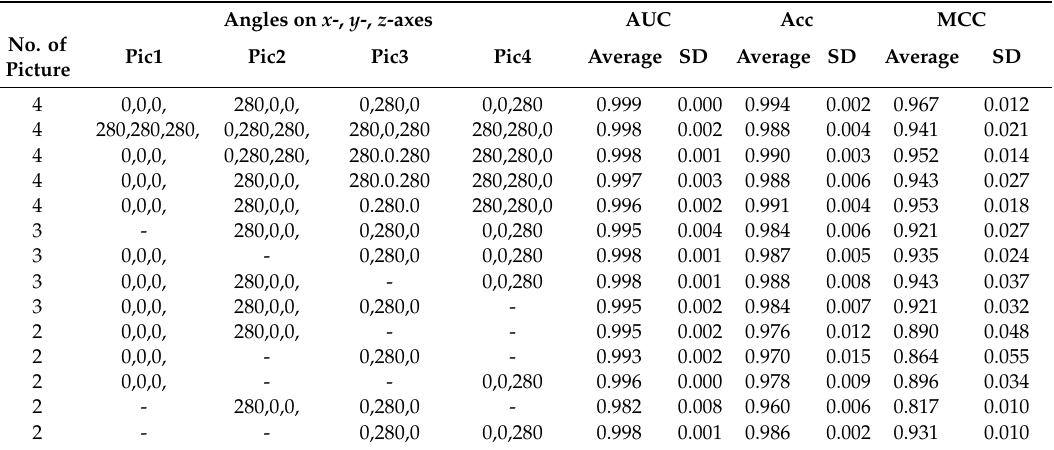
Table 3. Prediction performances with combinations of di ff erent angles in the DeepSnap. Angles on x -, y -, z